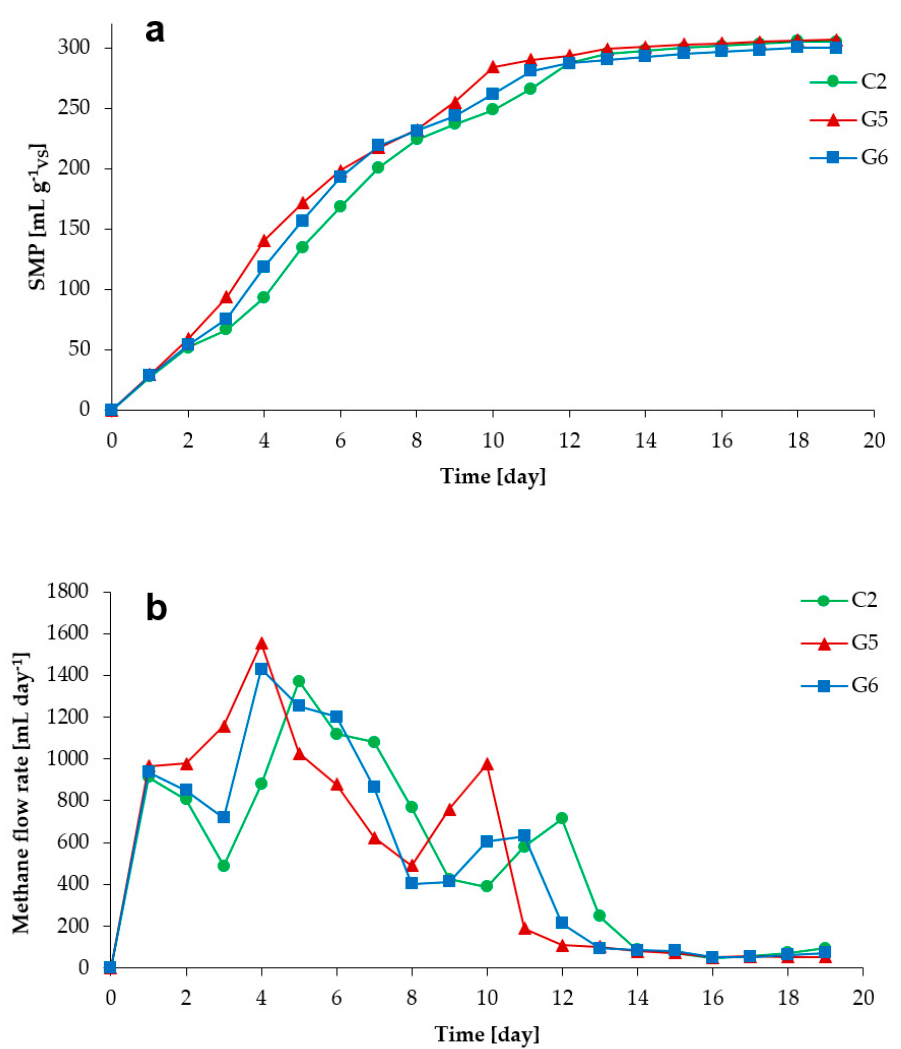
Figure 3. Effects of GAC addition on specific methane production ( a ) and methane flow rate ( b ) during the experimental period (ISR is 1.33). Different concentrations of GAC (0 g L − 1 , 5 g L − 1 , and 10 g L − 1 ) were added to reactors (C2, G5, and G6, respectively).